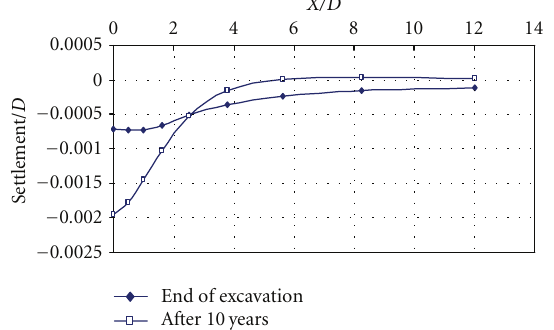
Figure 15: The surface settlement at the end of excavation and after consolidation using MCC soil model.